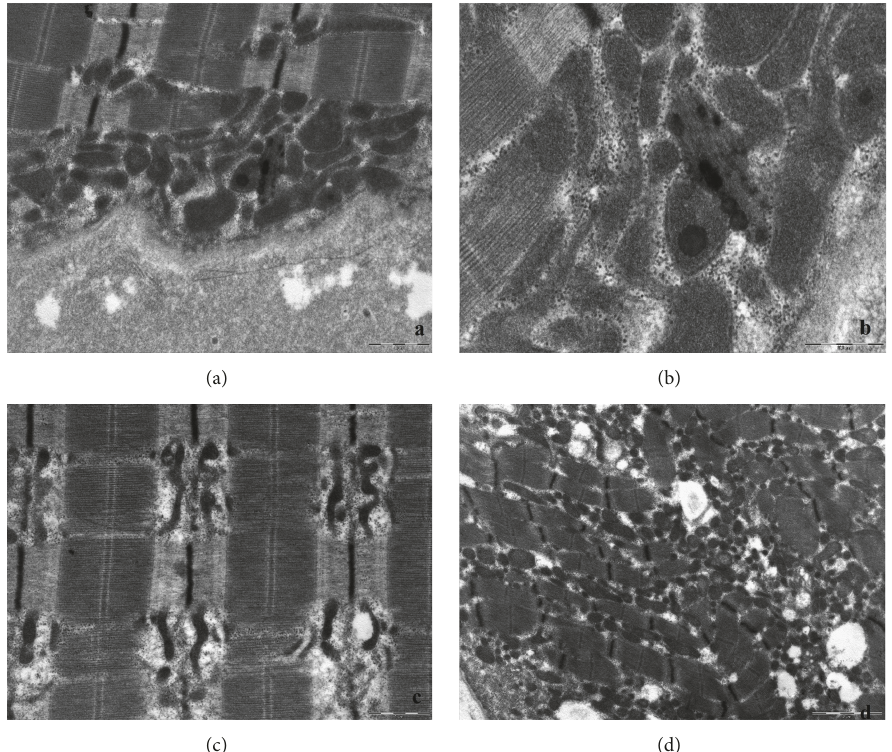
Figure 2: Ultrastructural examination on muscle: (a) and (b) show intra mitochondrial lipid inclusion; (c) mitochondria with transversal orientation to the myofiber; (d) mitochondrial